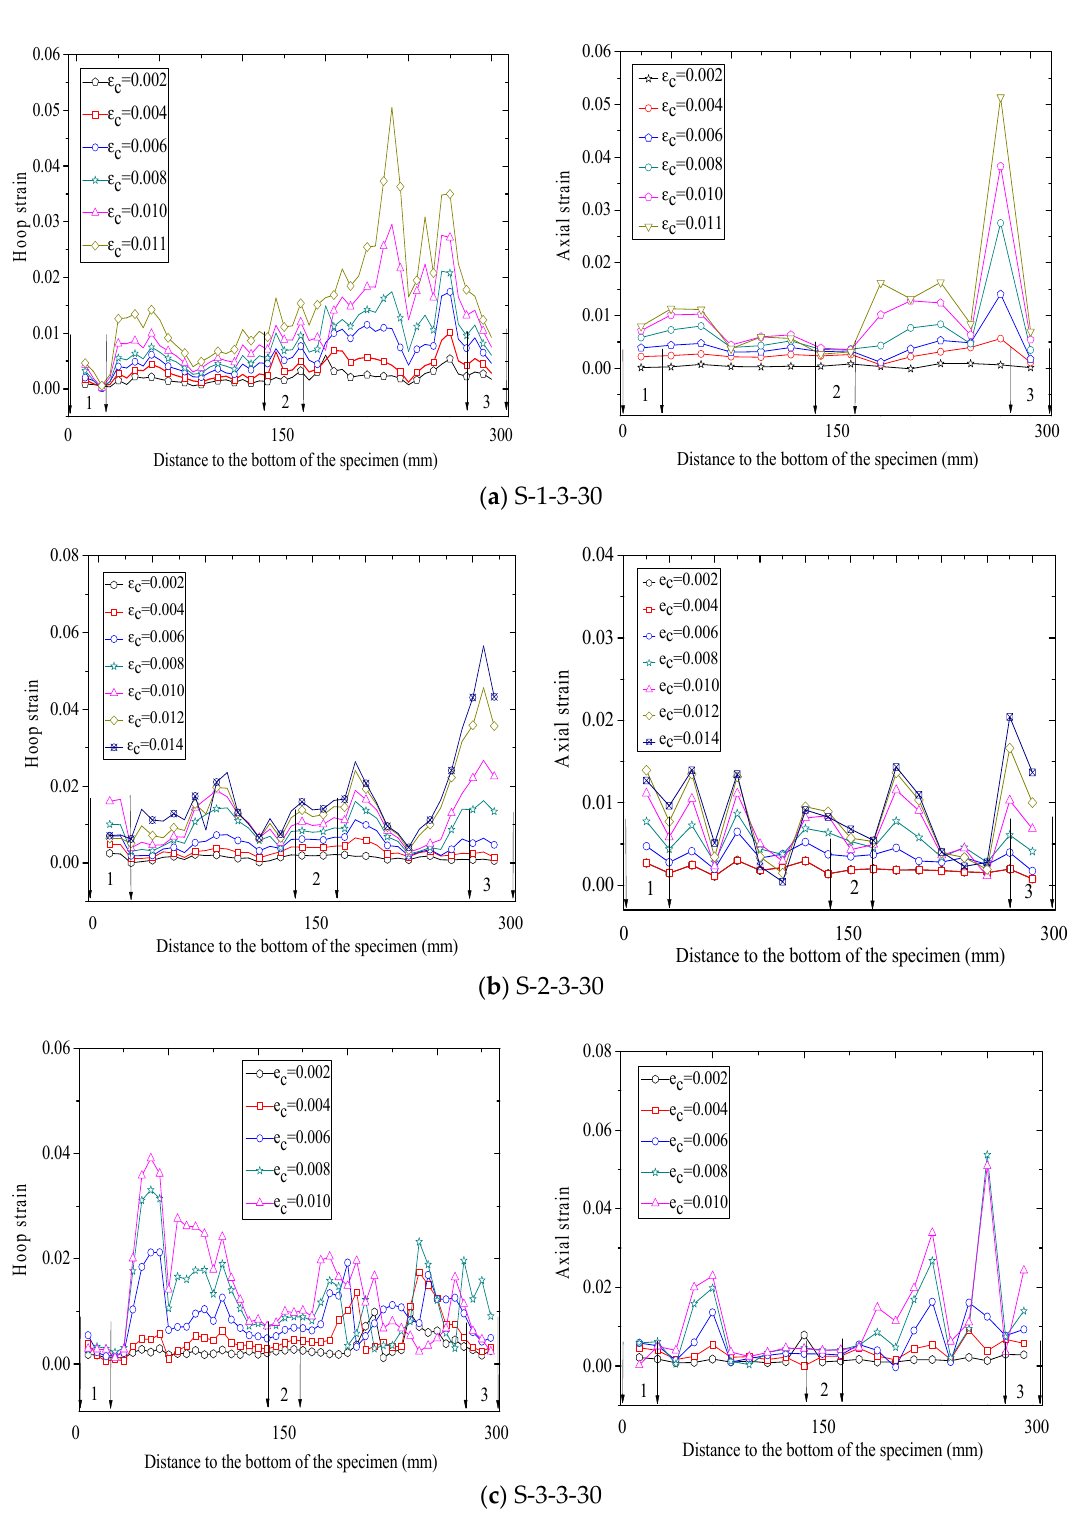
Figure 10. Strain distribution along the column height (specimens wrapped with three strips).